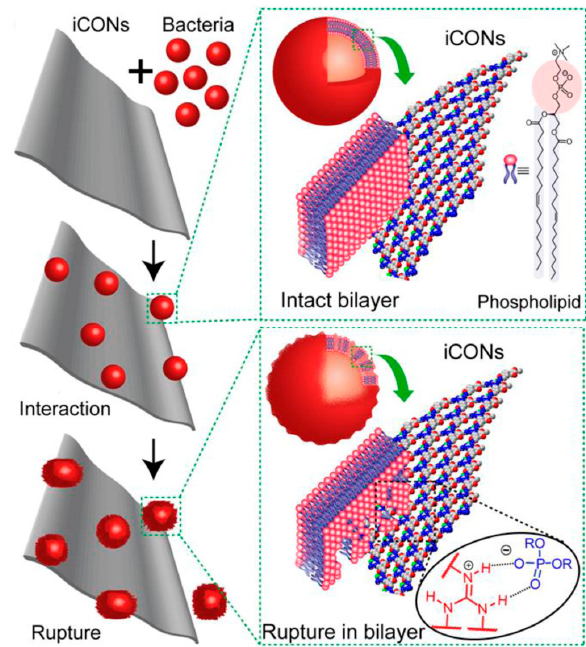
Figure 17. Schematic representations of iCONs for antimicrobial applications. Reproduced with permission from [235]. Copyright American Chemical Society, 2016.